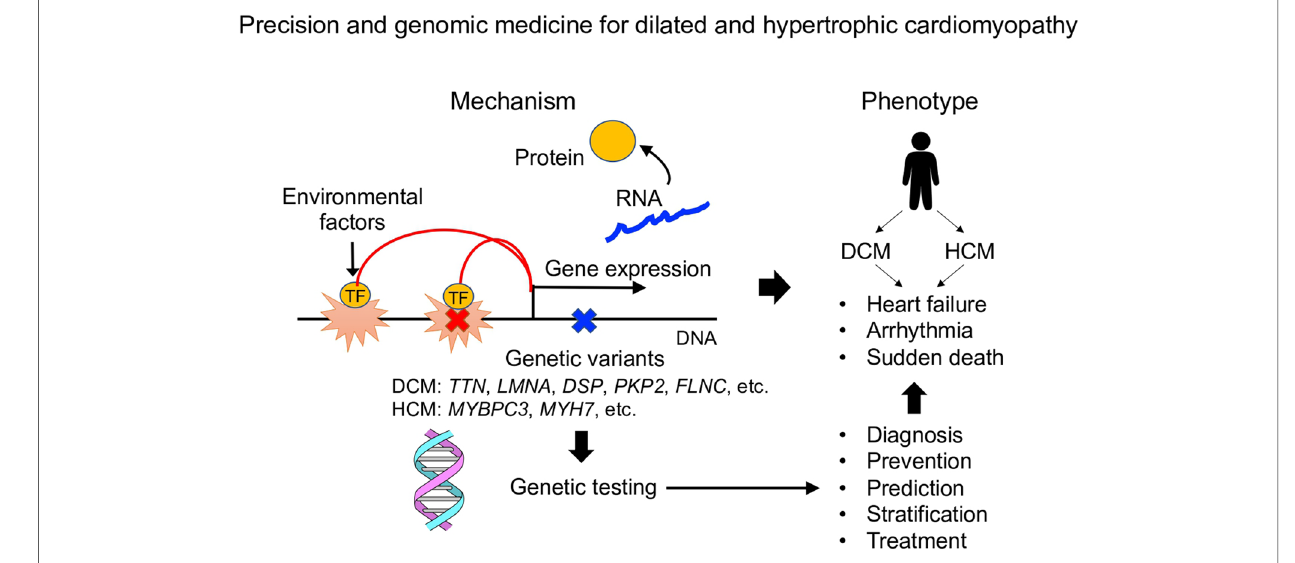
FIGURE 1 Overview of precision and genomic medicine for dilated and hypertrophic